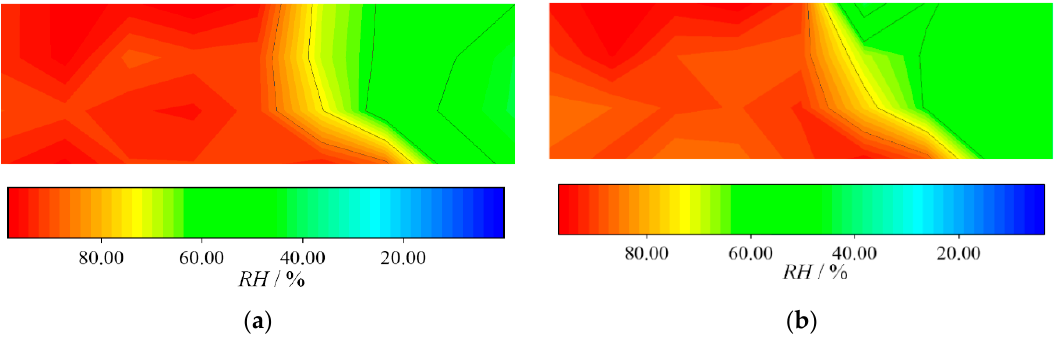
Figure 7. Experimental results for relative humidity ( RH ) distribution in the anode channel: ( a ) under current of 55.8 A, ( b ) under current of 167.4 A.